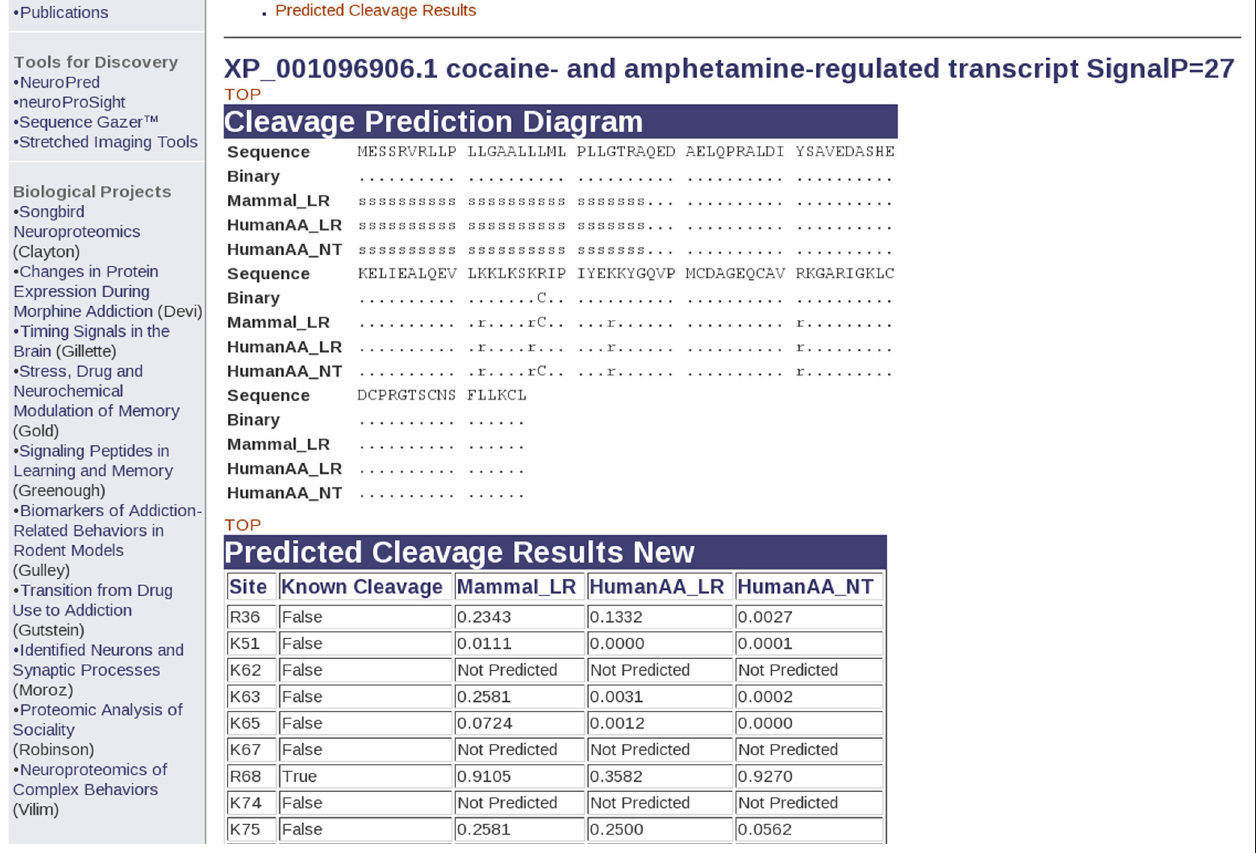
FIGURE 1 | Predicted cleavage sites of the rhesus cocaine- and amphetamine-regulated gene using different models in